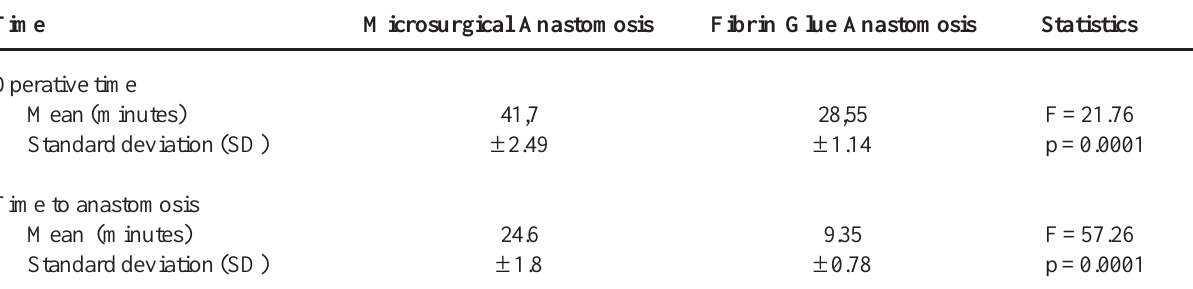
Table 5 – Comparison of anastomotic and operative time in vasovasostomy with conventional microsuture and fibrin